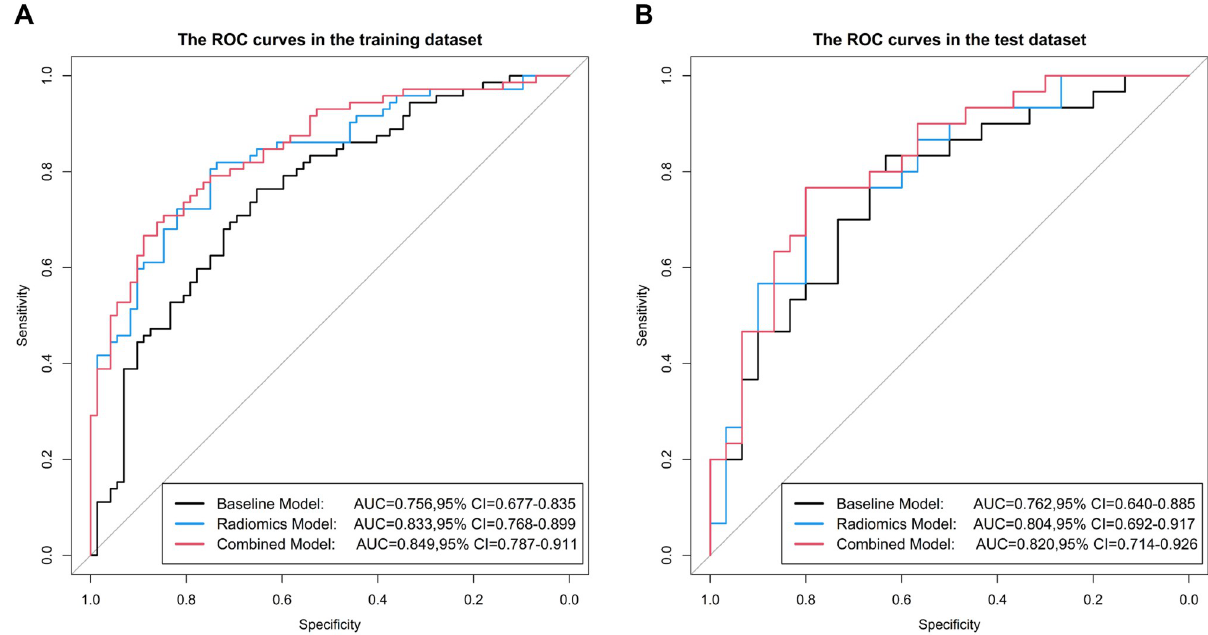
Fig 3. Receiver Operating Characteristic (ROC) curves of the three models for the training (A) and test (B) cohorts. AUC, area under the receiver operating characteristic curve; CI, confidence interval.